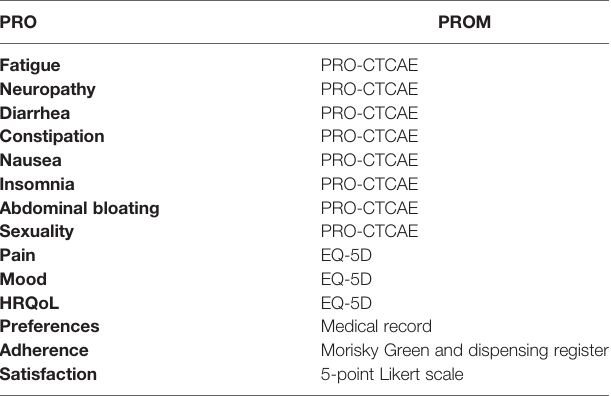
TABLE 2 | Final set of PROs and PROMs.